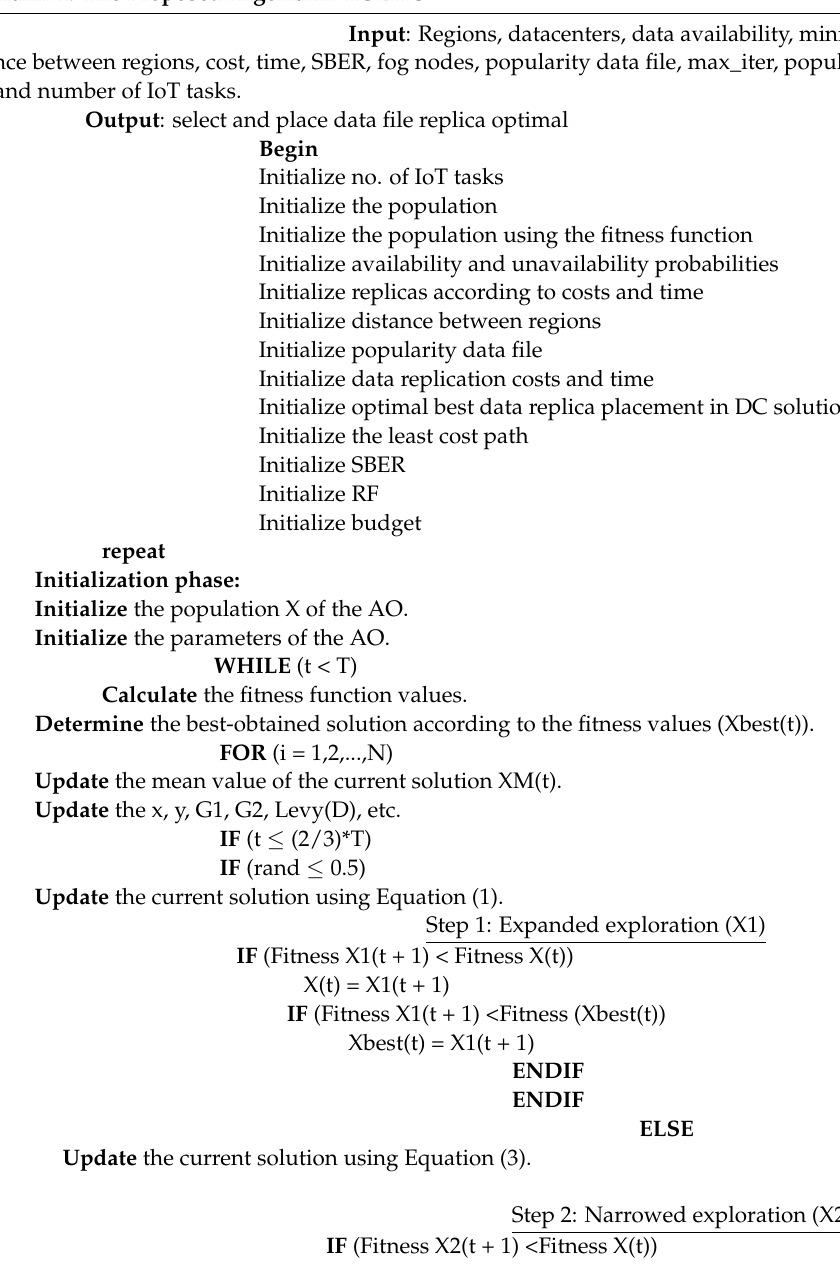
Algorithm 1: The Proposed Algorithm